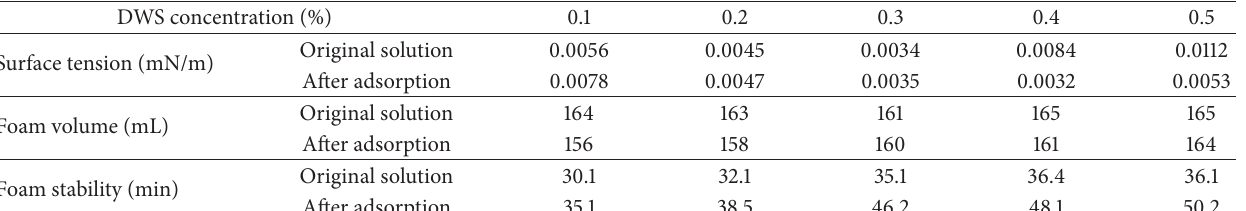
Table 1: Properties of DWS after adsorption in cores.